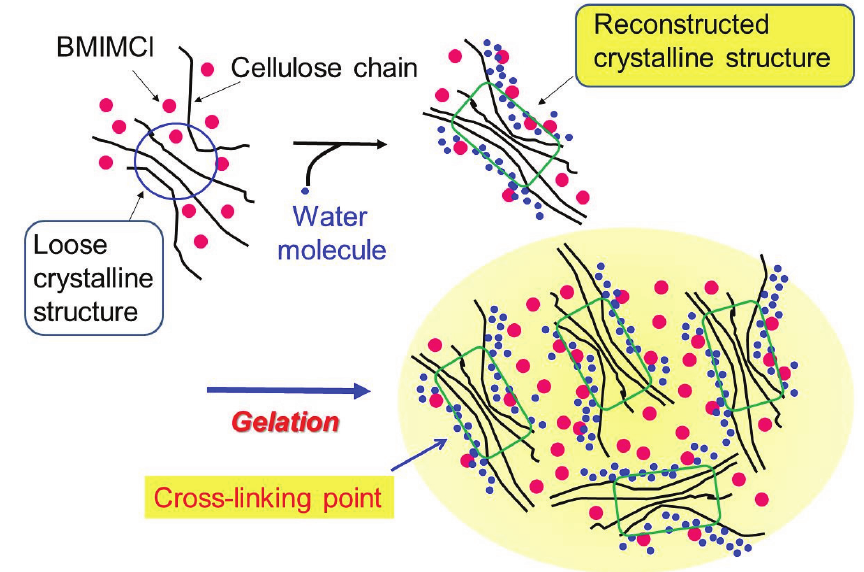
Figure 4. Procedure for fabrication of cellulose ion gel with 1-butyl-3-methylimidazolium chloride (BMIMCl).